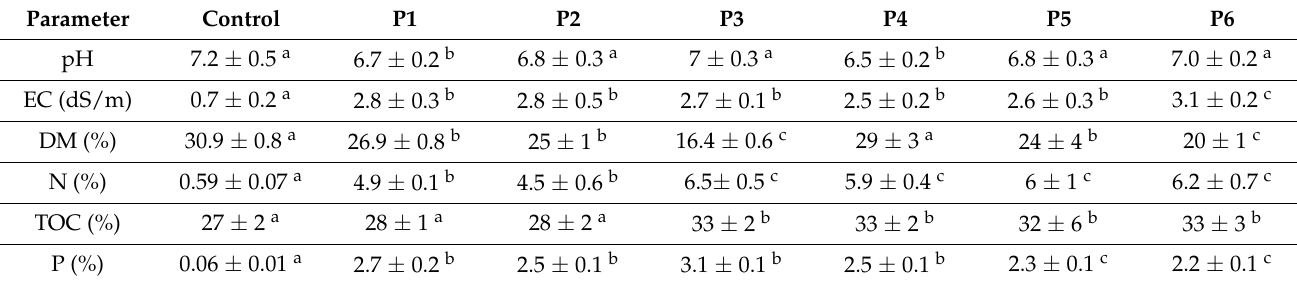
Table 1. Average physico-chemical characterization of SS from different WWTPs and control soil before remediation. Different letters indicate significant differences among samples for each analysed parameter (ANOVA/Kruskal-Wallis tests, followed by Tukey HSD/Dunn’s tests, p < 0.05). TOC: total organic carbon, EC: electrical conductivity, DM: dry matter. Complete dataset in Table